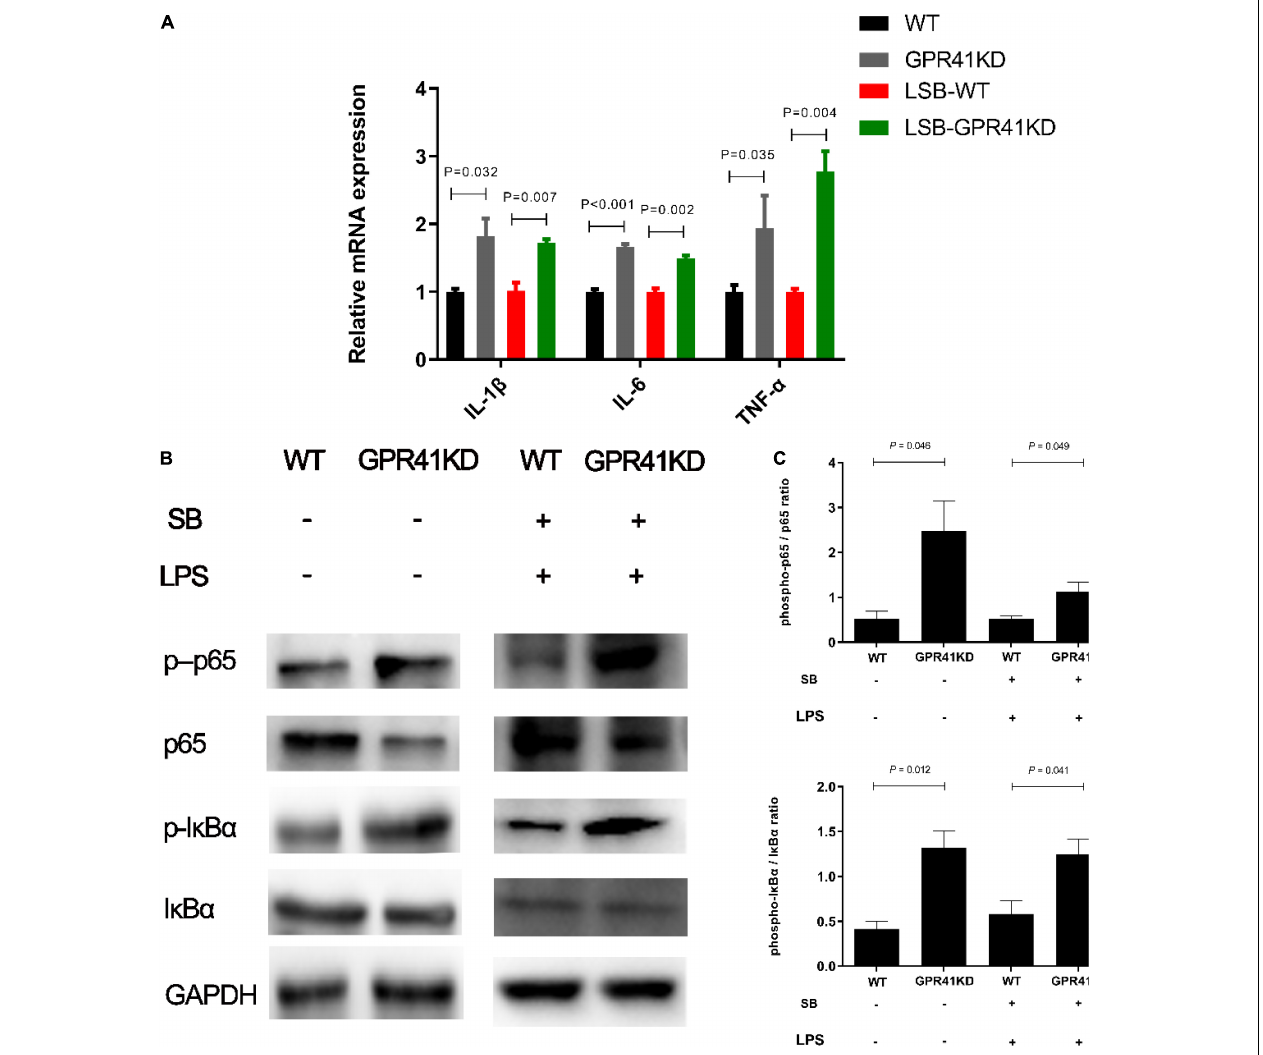
FIGURE 7 | Effect of GPR41 on genes and proteins related to inflammation. Generation of GPR41-knockdown (GPR41KD) BREC cell lines using the CRISPR/Cas9 system. Pretreatment with SB in BRECs and BRECEs-GPR41KD for 18 h then treated with 4 µ g/mL LPS for 6 h. After incubation, cells were analyzed by qRT-PCR and Western blotting. (A) Expression of genes related to the inflammatory response, normalized by GAPDH. (B,C) Immunoblotting and acquisition of intensity from the respective blots. The protein expression was normalized by the respective abundance of GAPDH. The values are shown as mean ± SEM ( n =